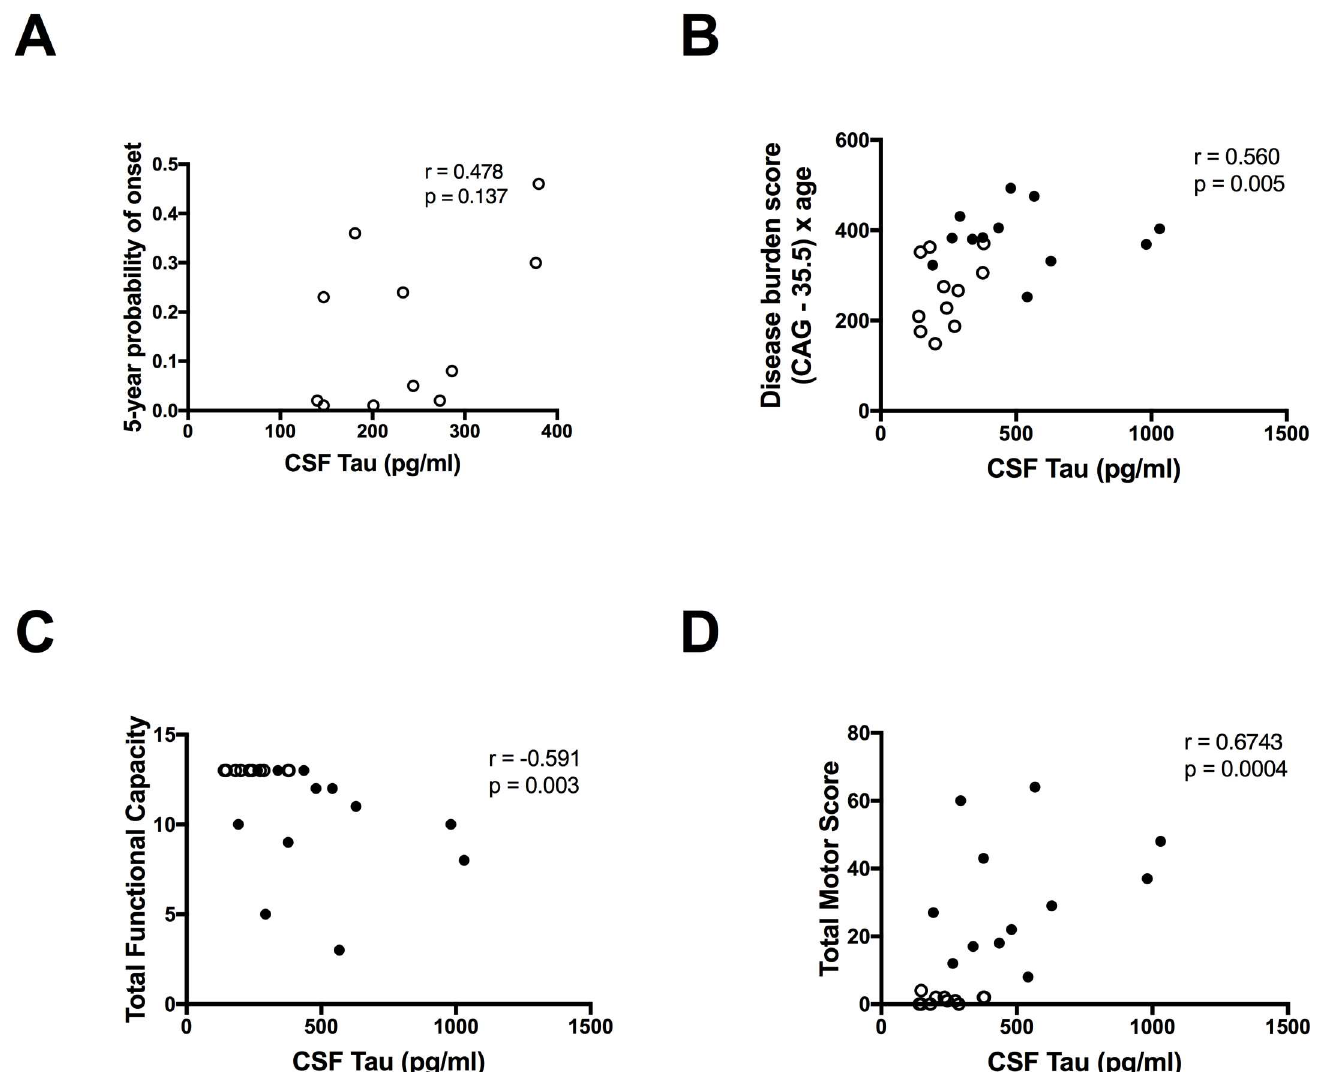
Fig 2. Correlations between tau and disease progression in Huntington’s disease. Tau does not correlate with ( A ) 5-year probalilityof disease onset but correlations with ( B ) diseaseburden, ( C ) total functionalcapacity, and ( D ) total motor score were significant. ○ Premanifest gene expansion carrier • Manifest Huntington’s